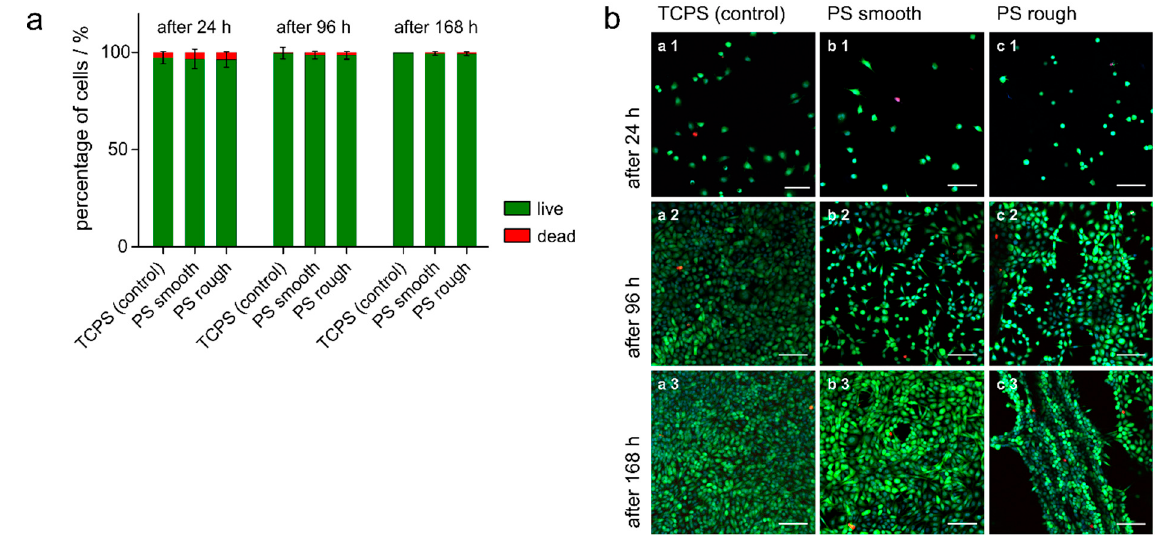
Figure 6. Results of the live/dead staining containing calcein-AM (green fluorescence, viable cells), PI (red fluorescence, dead cells) and Hoechst (blue fluorescence, all cells). Three independent experiments were carried out in triplicate. Four images per sample were taken (36 per condition per time point). ( a ) Percentages of live (green) and dead (red) L-929 cells grown on TCPS and FDM-printed PS substrates (smooth and rough surfaces) after 24 (left), 96 (middle) and 168 h (right). ( b ) Representative confocal LSM images of L-929 cells cultured for 24 (1), 96 (2) and 168 h (3) on TCPS (a) and FDM-printed PS substrates (b: smooth surfaces, c: rough surfaces) after a live/dead staining (scale bar 100 µm).